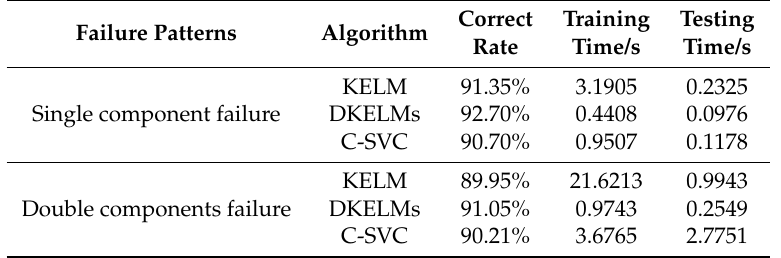
Table 10. Comprehensive performance comparison for component failure recognition.